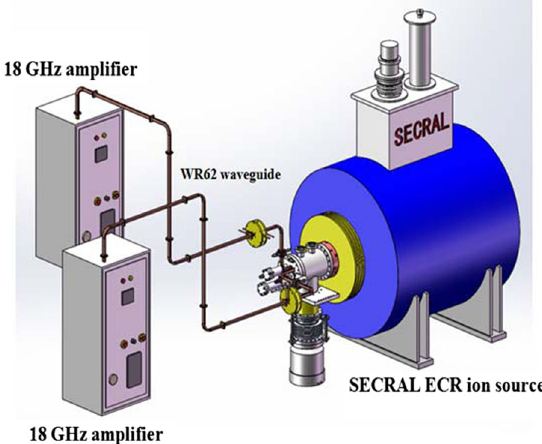
FIG. 10. SECRAL double waveguides coupling system both at 18